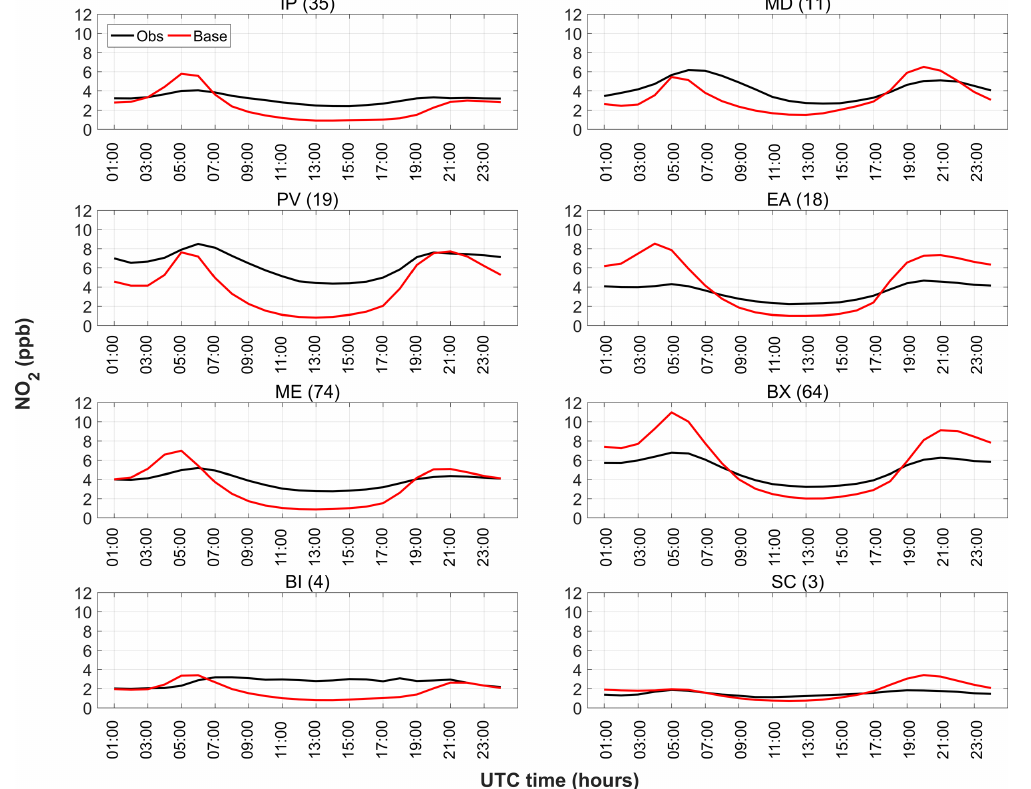
Figure 4. Diurnal profiles of the surface NO 2 mixing ratios in eight European regions in summer 2010. The number of stations available for each region is reported in parentheses at the top of each panel. A definition of the regions is given in Fig.